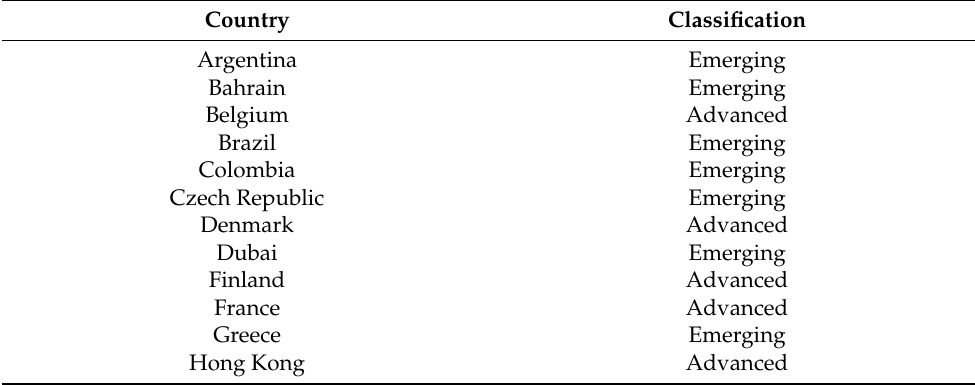
Table A1. Classification of emerging and advanced countries (following